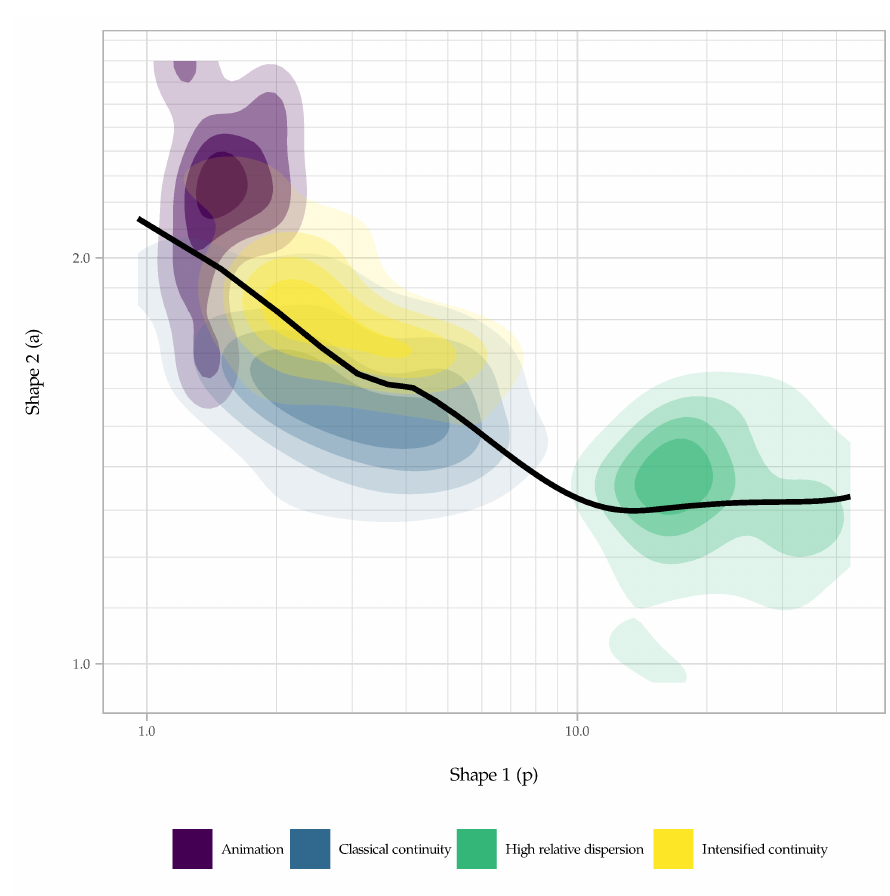
Figure 6 – 2-d density plots of Dagum shape parameters for the four main types of films in sample a 134 Hollywood films released from 1935 to 2005. (Source: Cutting et al. (2010); http://www.